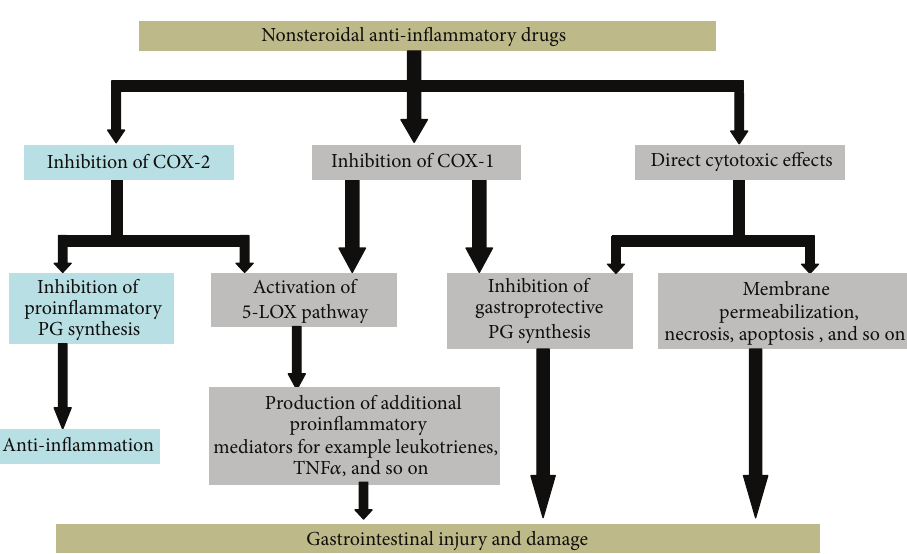
Figure 2: Schematic diagram of mechanism of NSAID-induced gastrointestinal injury and